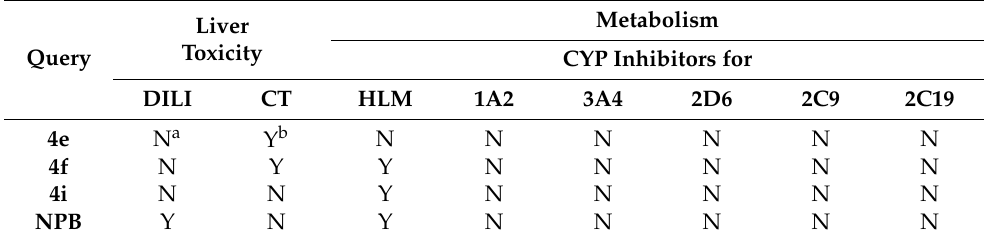
Table 4. The vNN-ADMET predictions for active compounds 4e, 4f and 4i.